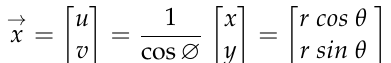
Figure 8. Brick detection and its corresponding four-point marks using YOLOv4 [55] in ( a ) sonar image and ( b ) stereo image pair.